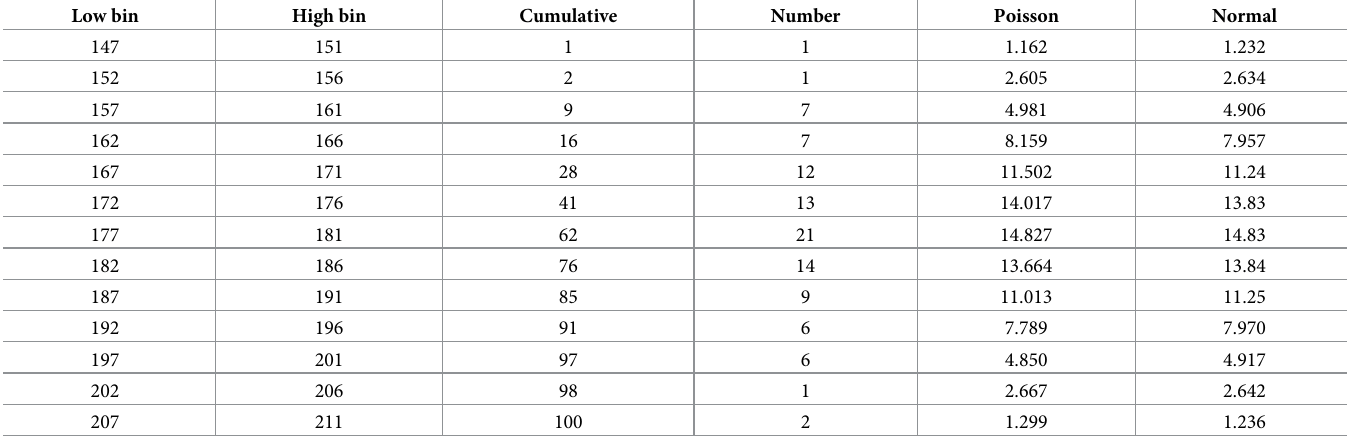
Table 3. Binning of measured data with estimations from Poisson distribution and normal distribution approximation.